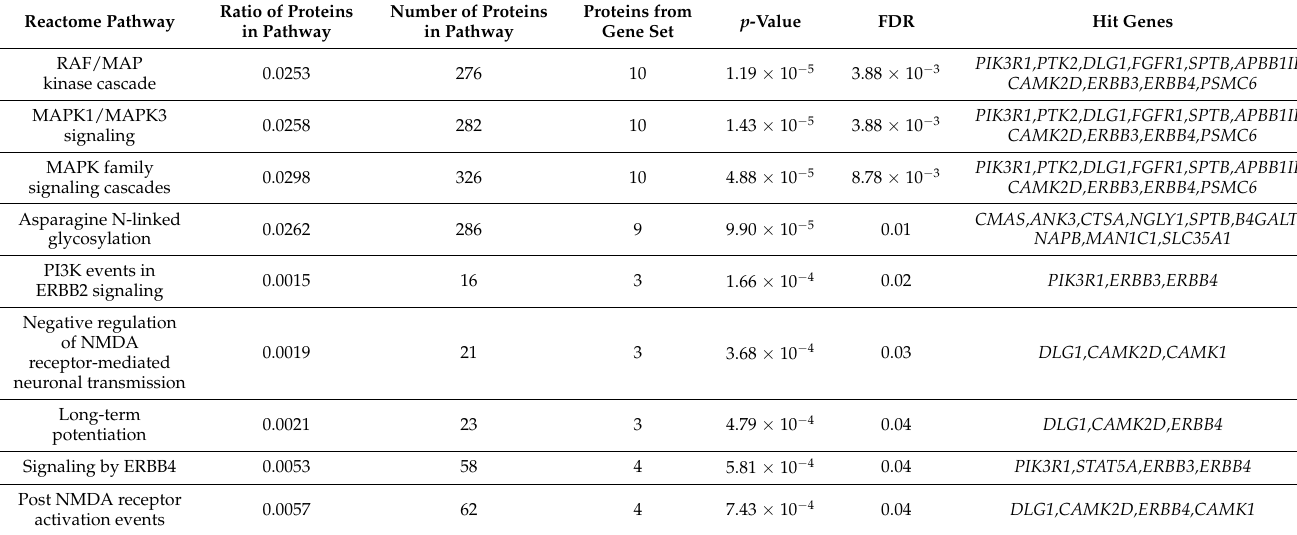
Figure 5. Protein interaction network of a combination of genes with upstream, 5 (cid:48) and 3 (cid:48) UTR variants generated by STRING. Proteins surrounded by violet circles represent genes with 5 (cid:48) UTR variants and those surrounded by red circles represent genes with 3 (cid:48) UTR variants; proteins with red filling belong to the MAPK pathway and those with blue filling belong to the ErbB pathway; some proteins, due to their involvement in both pathways, are filled with both red and blue. The density of the connecting lines between the protein nodes in the figure represents the interaction score, highlighting the importance of the MAPK and ErbB pathway-related proteins. Table 3. Reactome pathway enrichment analysis for combined 5 (cid:48) and 3 (cid:48) UTR